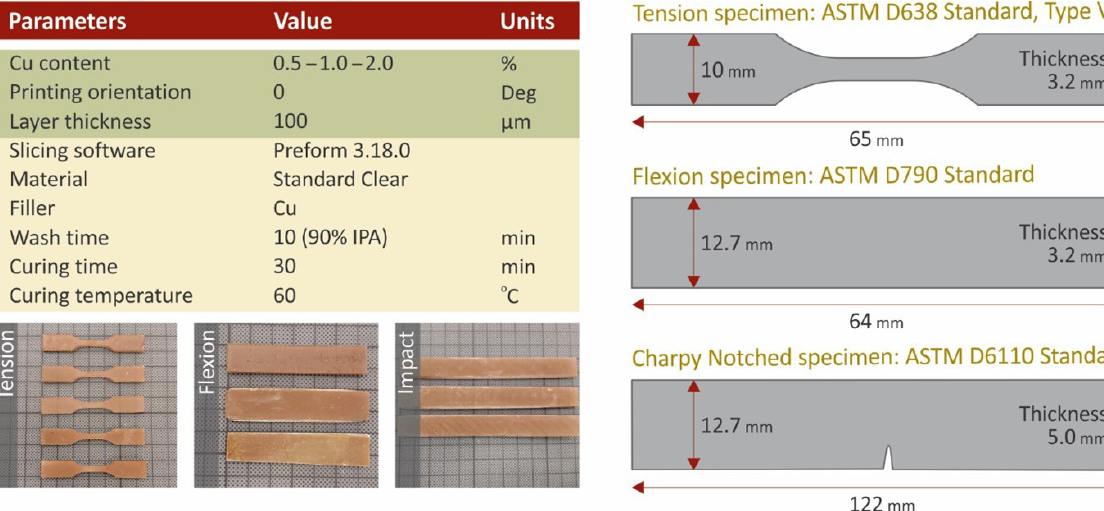
Figure 2. Fundamental SLA 3D printing settings, specimens’ dimensions, and images from 3D printed specimens.